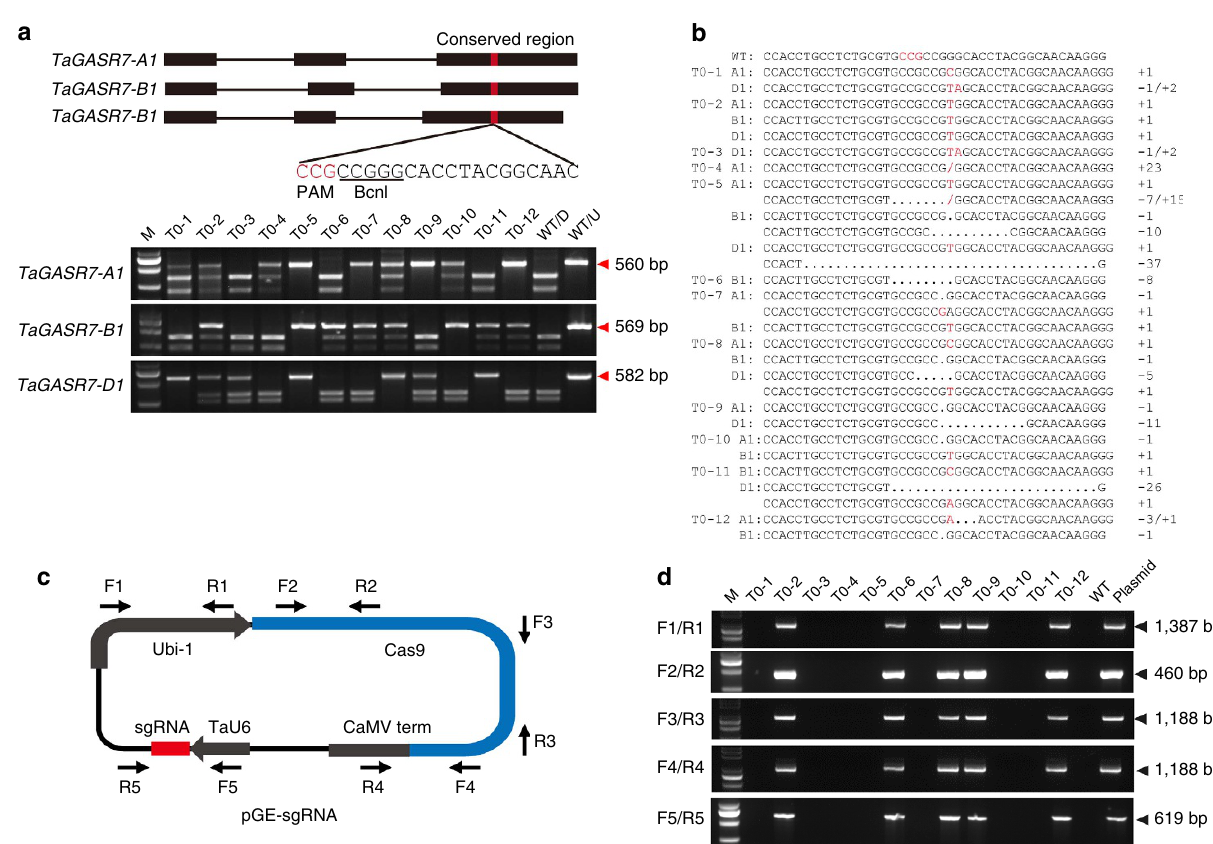
Figure 2 | Development and validation of the TECCDNA method. ( a ) Sequence of an sgRNA designed to target a site within a conserved region of exon 3 of TaGASR7 homoeologues. The protospacer-adjacent motif (PAM) sequence is highlighted in red and the BcnI restriction site is underlined. The outcome of PCR-RE assays analysing 12 representative tagasr7 mutants is shown. Lanes T0-1 to T0-12 show blots of PCR fragments amplified from independent wheat plants digested with BcnI. Lanes labelled WT/D and WT/U are PCR fragments amplified from WTplants with and without BcnI digestion, respectively. The bands marked by red arrowheads are caused by CRISPR/Cas9-induced mutations. ( b ) Genotypes of 12 representative mutant plants identified by sequencing. ( c ) Schematic of the structure of the pGE-sgRNA vector and five primer sets used for detecting transgene-free mutants. sgRNA refers to sgRNAs targeting TaGASR7, TaDEP1, TaNAC2, TaPIN1, TaLOX2, TdGASR7 and TaGW2 , respectively. ( d ) Outcome of tests for transgene-free mutants using five primer sets in 12 representative tagasr7 mutant plants. Lanes without bands identify transgene-free mutants. Lanes labelled WTand plasmid show the PCR fragments amplified from a WT plant and the pGE-TaGASR7 vector,